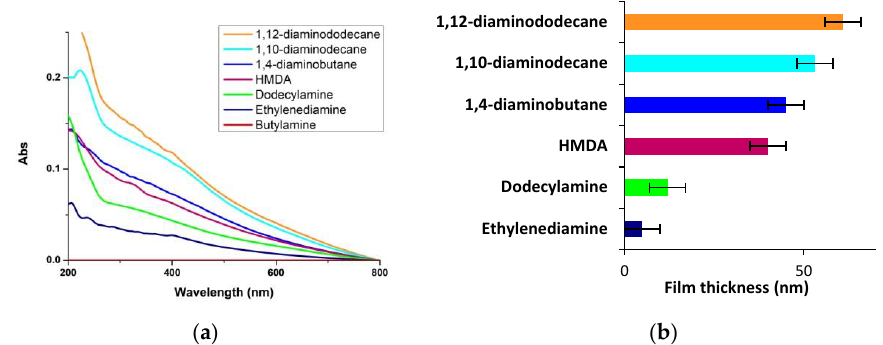
Figure 2. Ultraviolet–visible (UV–vis) and film thickness analysis. ( a ) UV–vis spectra of quartzes dipped into 1 mM solution of dopamine in 0.05 M carbonate buffer (pH 9.0) in the presence of equimolar amounts of various amines over 24 h. ( b ) Average film thickness as determined by atomic force microscopy (AFM). Data are shown as mean ± standard deviation (SD) of three independent experiments.